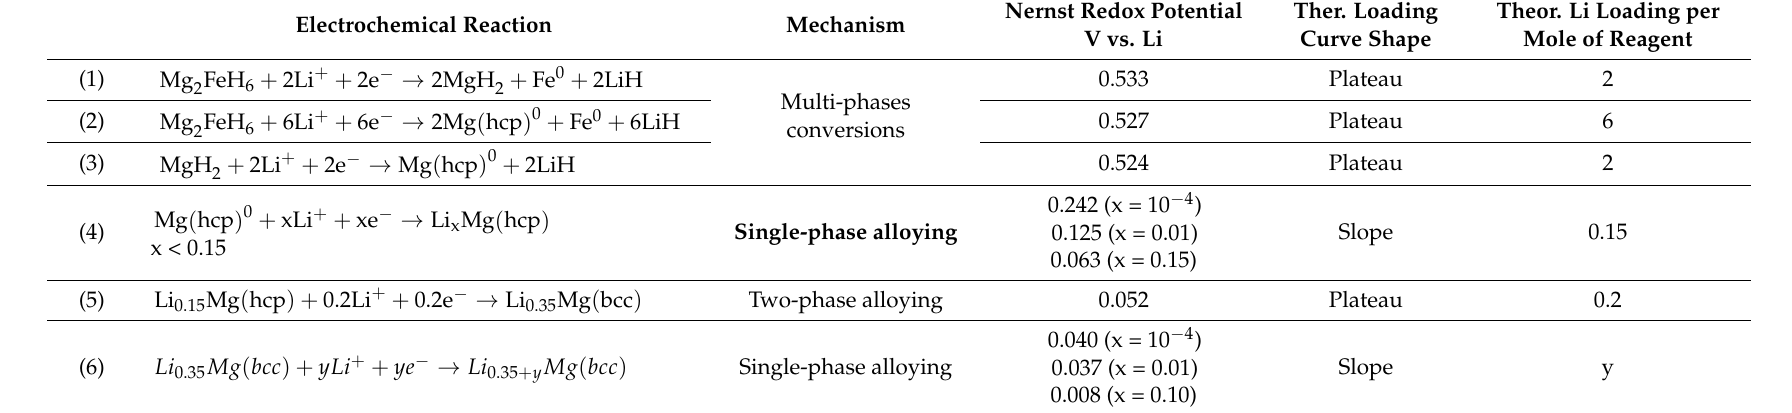
Table 2. Thermodynamic analysis of the conversion reactions of the Fe-H-Mg